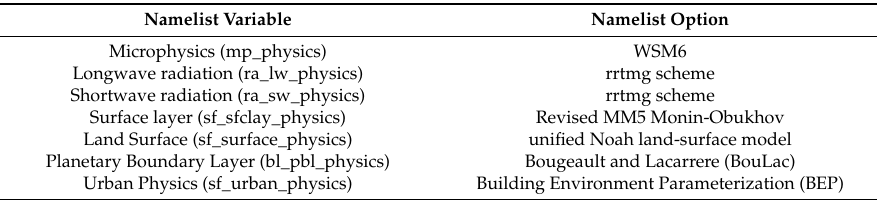
Table 2. Physics options used in the namelist input file for WRF